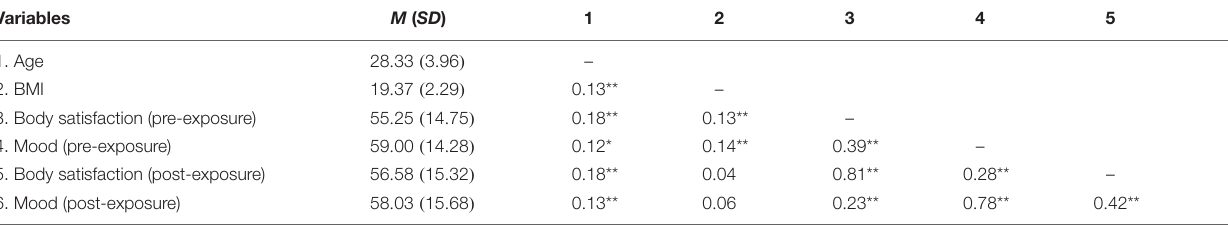
TABLE 1 | Descriptive statistics and Pearson correlation for the key variables.